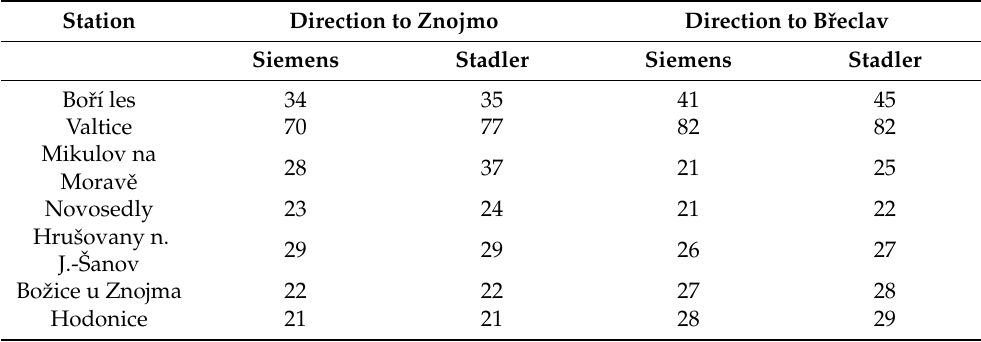
Table 7. Traction energy consumption [kWh] of stops in intermediate stations on the line 246.